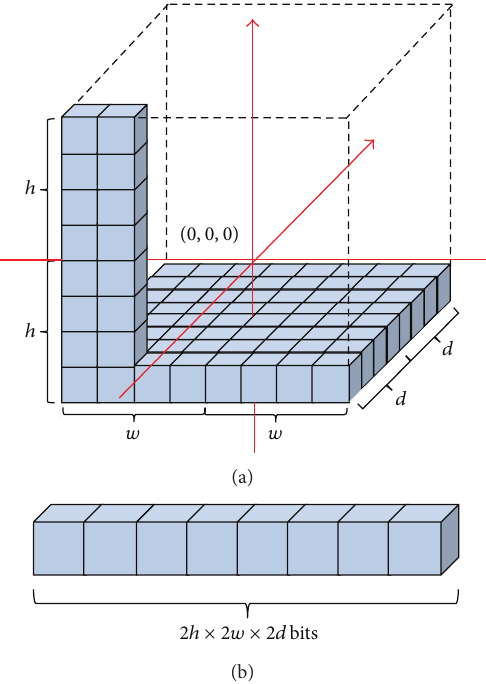
Figure 2: Definition of voxel-based flag map. (a) A space of regular voxels. (b) A buffer stream of 2ℎ × 2𝑤 × 2𝑑